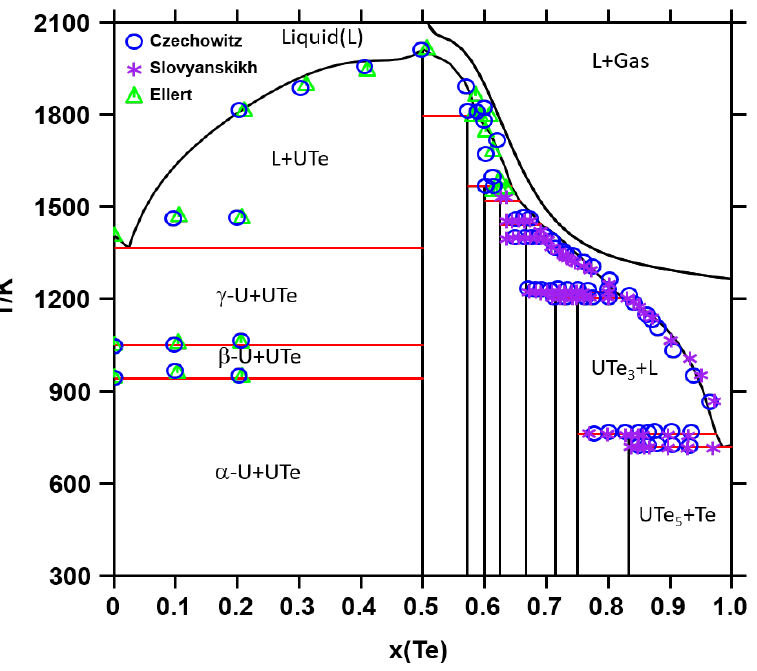
Figure 2. Calculated phase diagram. Comparison with the experimental data from Czechowitz [19], Slovyanskikh et al. [13] and Ellert et al. [18].